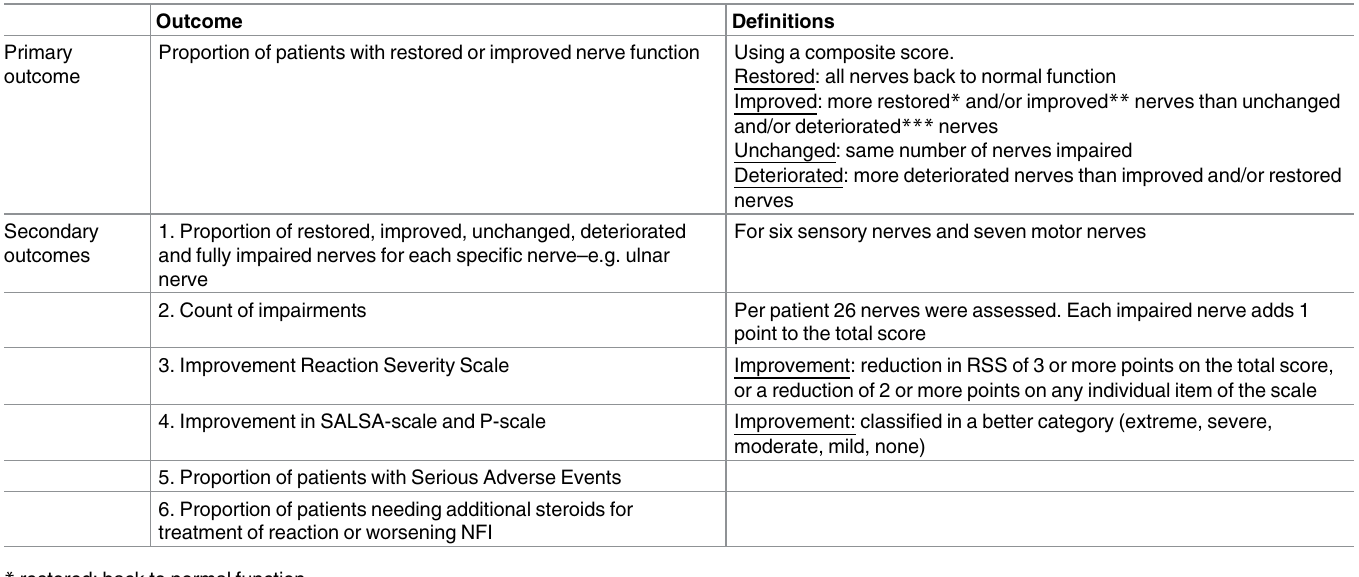
Table 1. Overview of primary and secondary